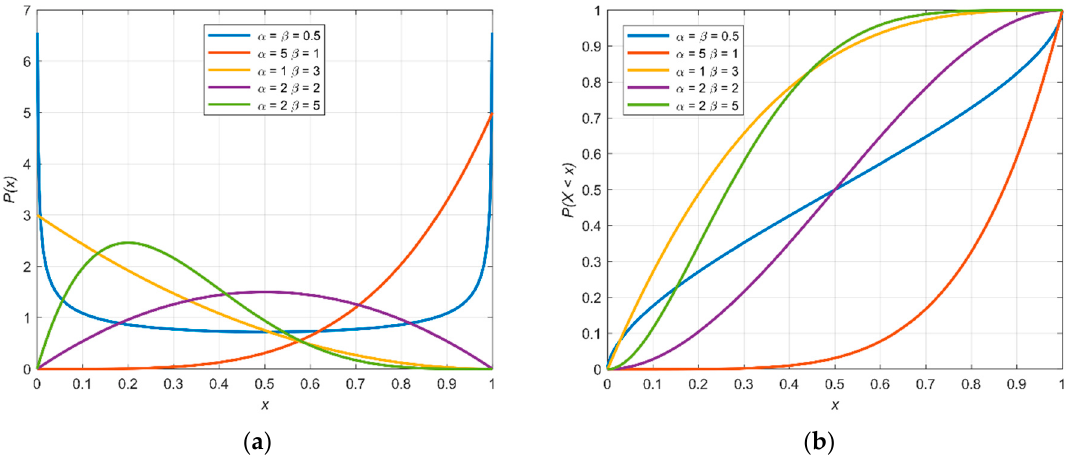
Figure A2. Beta distribution: ( a ) Probability & ( b ) Cumulative Distribution Functions. The analytical expression of the single variable Beta PDF is formulated as: